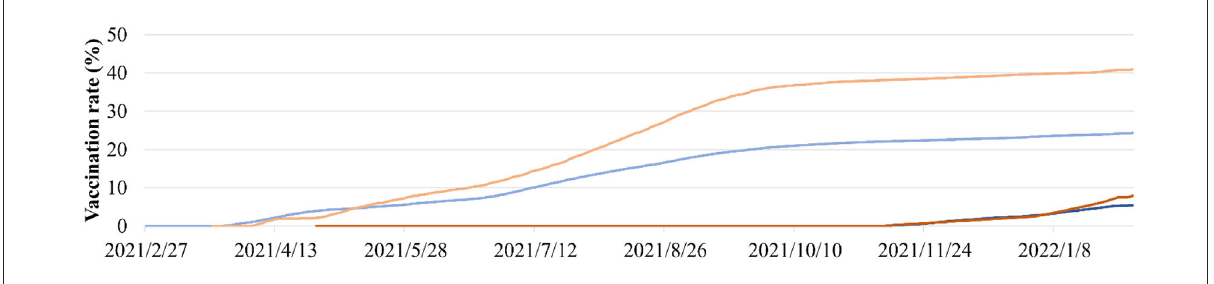
FIGURE1 The daily full and booster variation rates of Sinovac and BioNTech vaccine in Hong Kong from February 22nd, 2021 to February 4th, 2022.